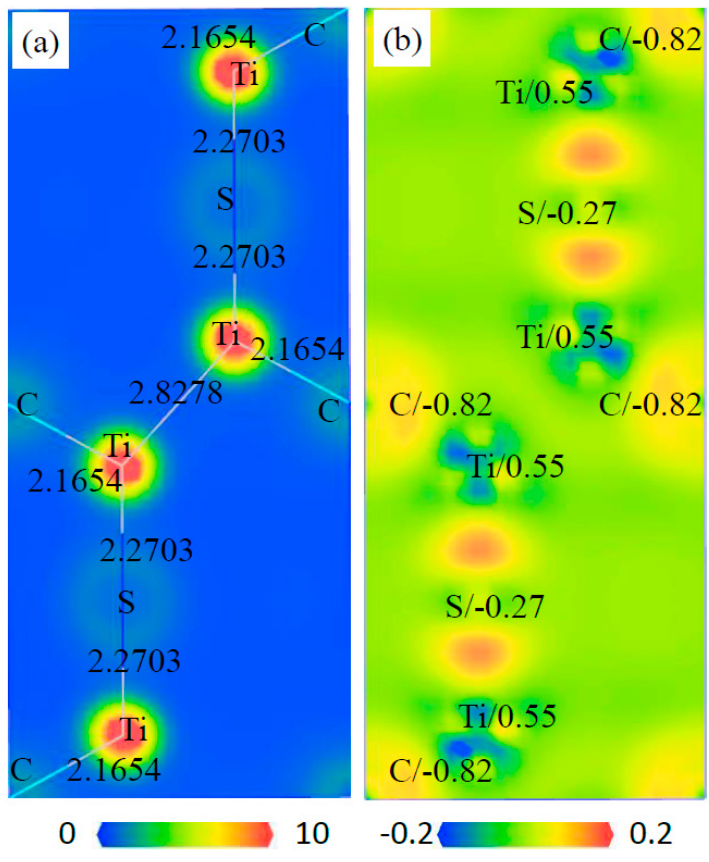
Figure 10. Electron density maps of the (110) plane in Ti 4 C 2 S 2 , ( a ) total electron density map from 0 to 10 (e/Å 3 ) and the bond length (Å), ( b ) electron density difference map (e/Å 3 ) and the atomic populations (e).